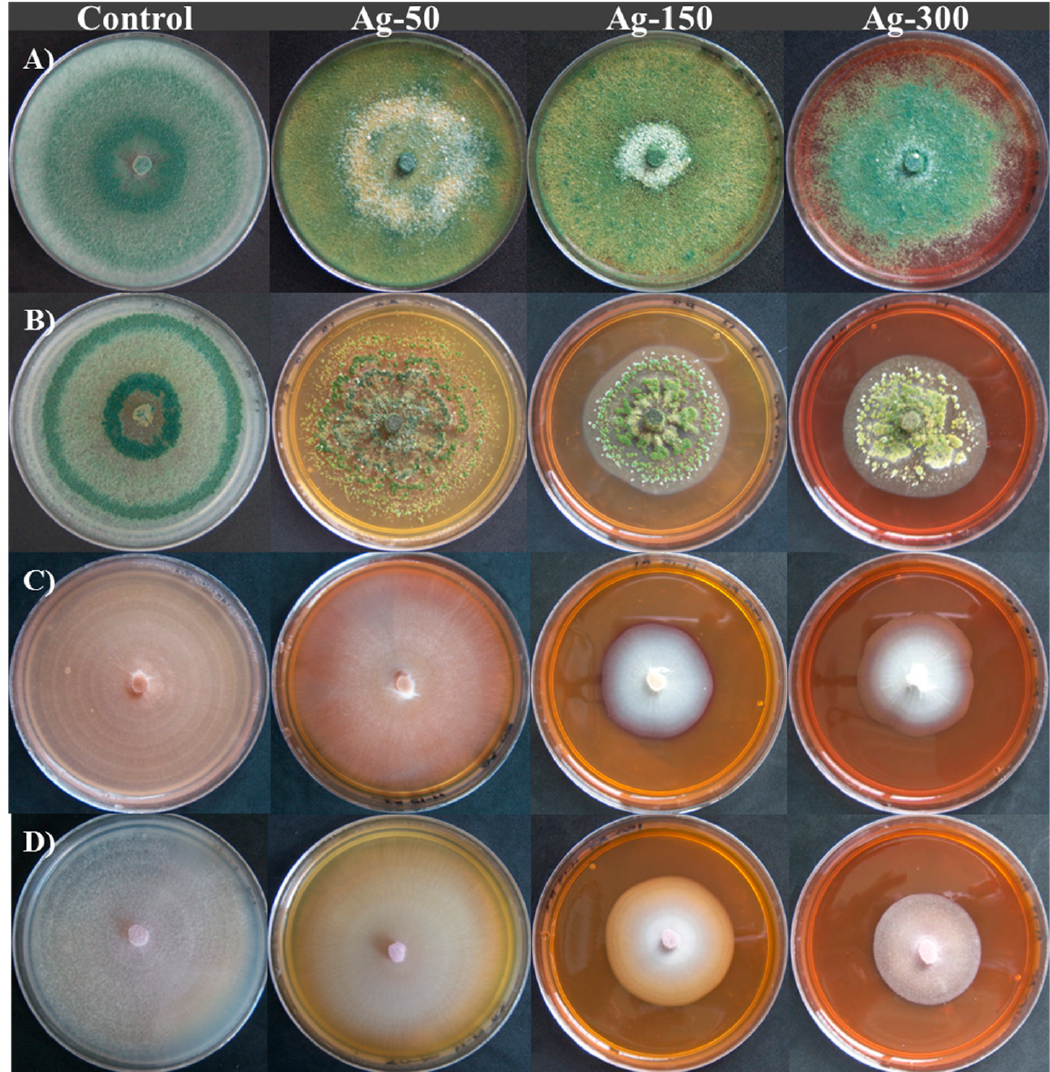
Figure 6. Morphological changes of four filamentous fungi exposed to four doses of silver for 20 days. ( A ) Trichoderma viridescens MX1, ( B ) Hypocrea lixii MXPE12, ( C ) Fusarium solani MXPE15 and ( D ) Fusarium oxysporum MX17.